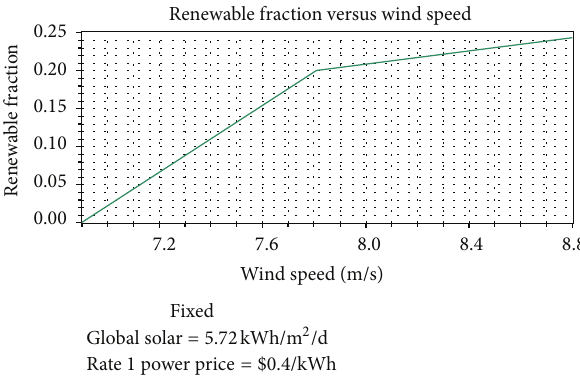
Figure 16: The relationship between RF and wind speed.